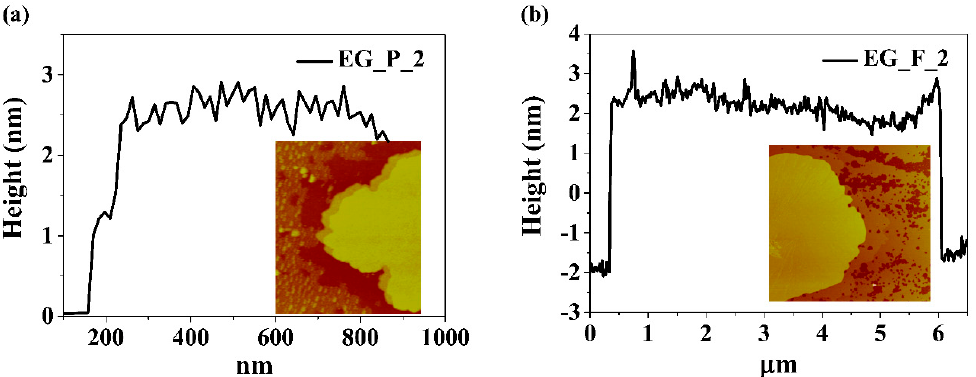
Figure 6. Atomic force microscopy (AFM) analysis together with height profile of ( a ) EG_P_2, ( b ) EG_F_2.